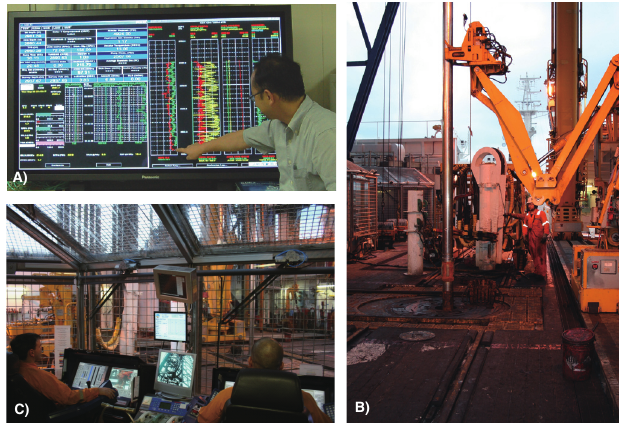
Figure 3. LWD drilling operations during Expedition 314. [A] Real time monitoring in the lab area; [B] LWD toolstring on the rig floor; [C] Driller’s house operations.